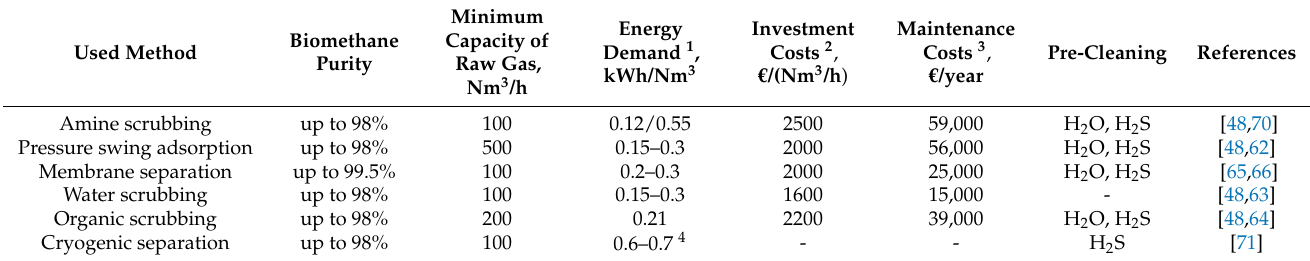
Table 2. Comparison of commercially available methods of biogas purification.